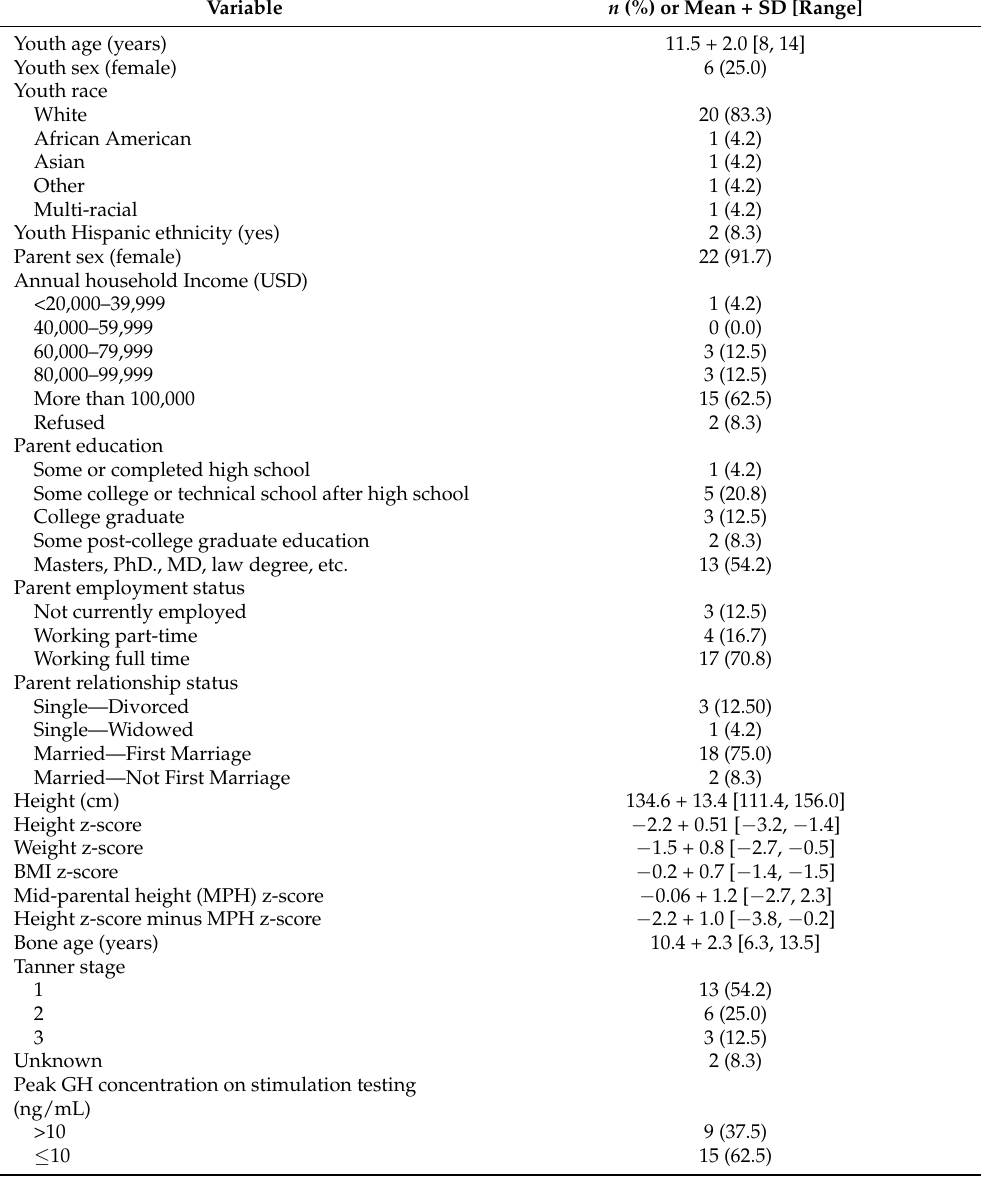
Table 1. Demographic and Patient Characteristics for Participants who Completed the Baseline Interview ( n =